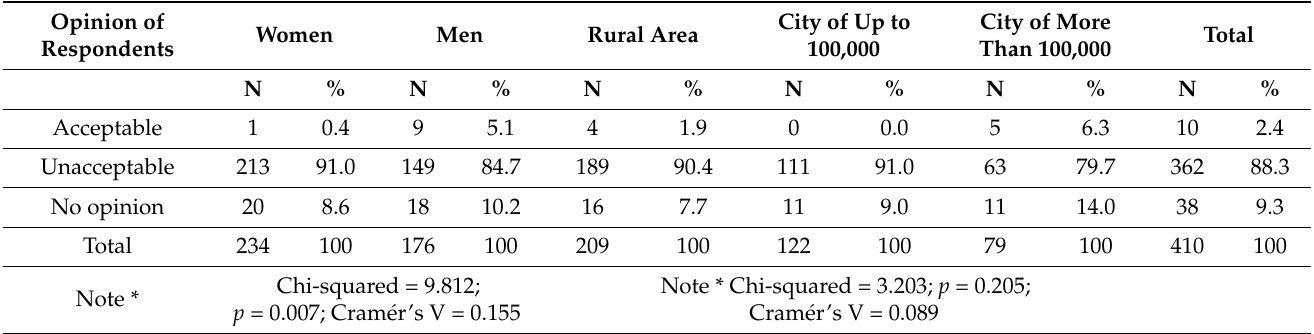
Table 3. Moral evaluation of marital infidelity.